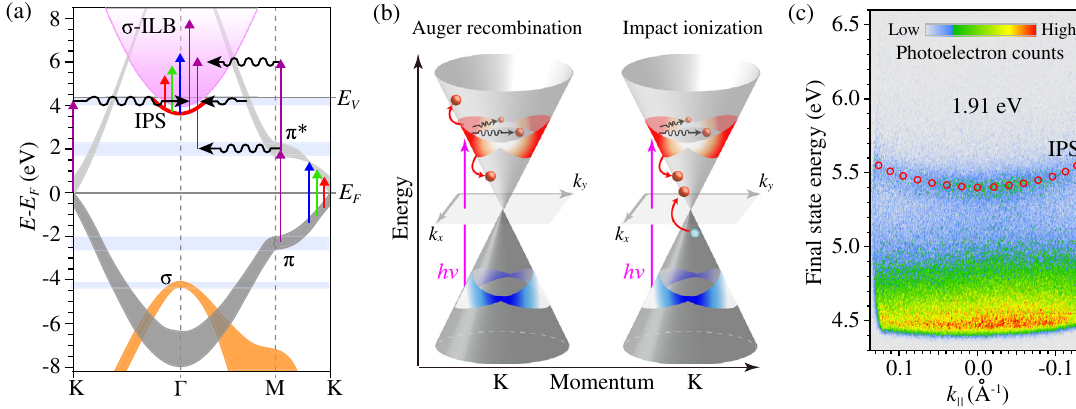
FIG. 1. (a) The k ∥ band structure of graphite in the Γ -M-K direction. The bandwidths represent the perpendicular band dispersions. Resonant optical absorption from IR to UV in graphite occurs by vertical dipole transitions between the π and π (cid:1) bands. Light blue shaded rectangles denote regions of high densities of states (van Hove singularities), where intervalley momentum scattering among the σ and π bands is particularly strong. Hot electron thermalization populates the image potential state (IPS; the red curve) and the 3D interlayer σ band (ILB; pink shaded area); the former is detected by one-photon photoemission, and the latter is the source of thermionic emission. Electron-phonon scattering (wavy arrows) mediates indirect 2PP, which is initiated by π - π (cid:1) excitation, and it also transfers hot electron population among the σ and π bands. (b) The primary photoexcited density is distributed anisotropically in circular cross sections through the Dirac cones at energies that are connected by the π - π (cid:1) transition with the maximum density perpendicular to the propagation vector of the excitation light ( k x ). Red above and blue below E F denote the primary hot electrons and hot holes; dark grey represents the occupied states prior to excitation. The primary distribution is thermalized within 25 fs by e - e scattering processes; Auger recombination causes carrier heating, whereas carrier multiplication by impact ionization is suppressed by limited phase space for the collinear process. Simultaneously, momentum is randomized by e - p scattering (wavy arrows). (c) A typical E ð k Þ mPP spectral distribution plotting the final photoelectron energy E vs parallel momentum k of graphite for p -polarized h ν ¼ 1 . 91 eV excitation. The dispersive IPS (indicated by red circles) is superimposed on a TES background, whose counts decay exponentially above the work-function edge at 4.4